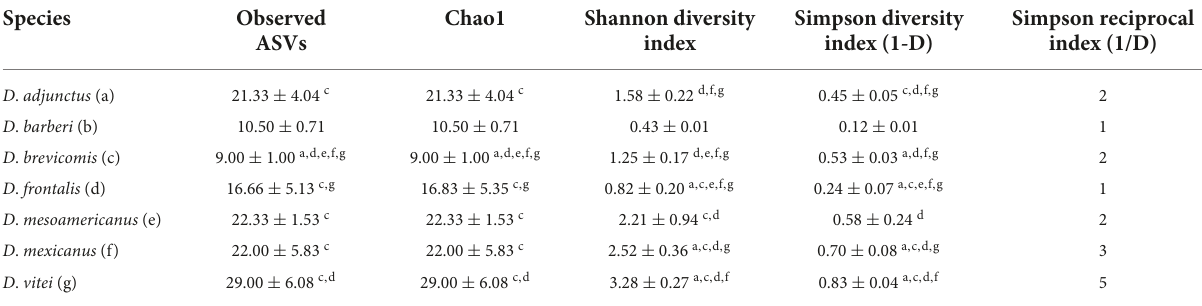
TABLE 2 Amplicon sequence variant (ASVs) richness and diversity indexes of the mycetangial fungi assemblages from the species of the Dendroctonus frontalis complex. Species Observed Chao1 Shannon diversity ASVs